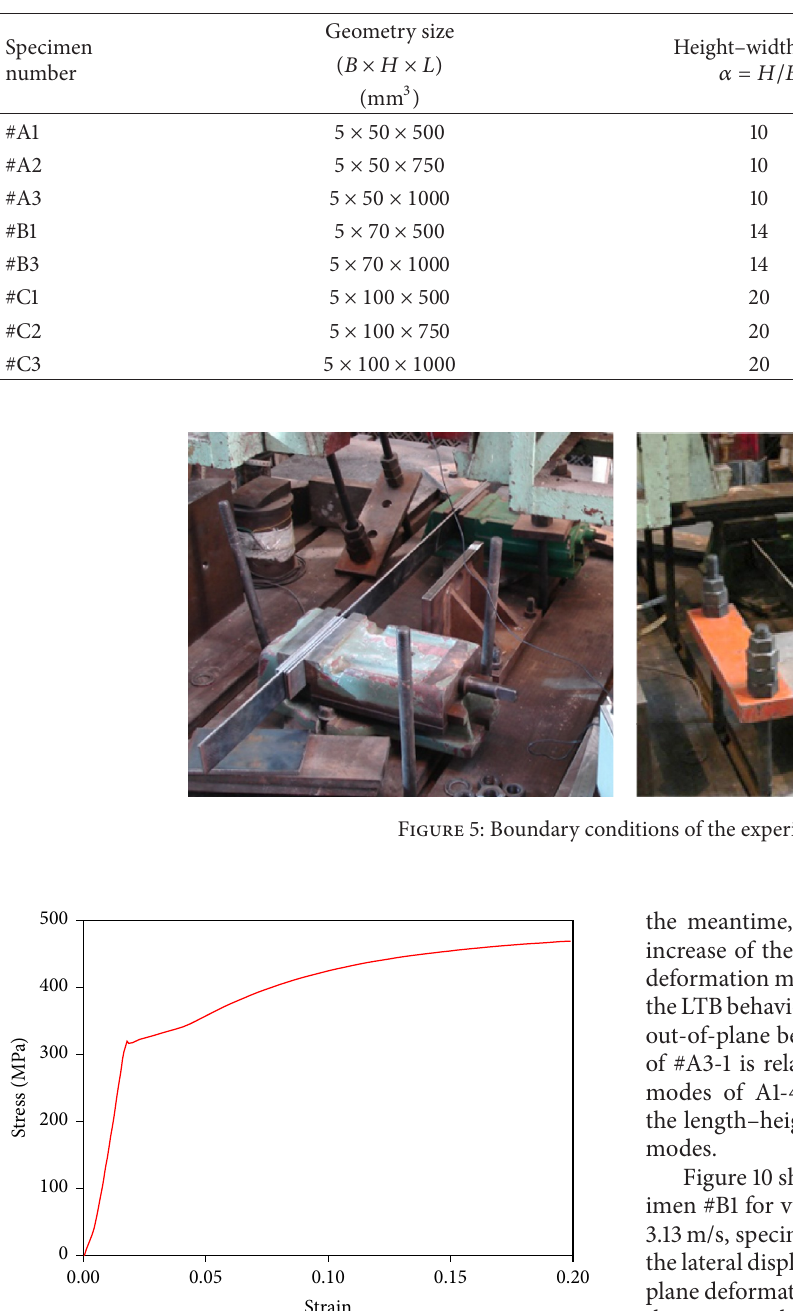
Table 1: Specifications of test specimens.